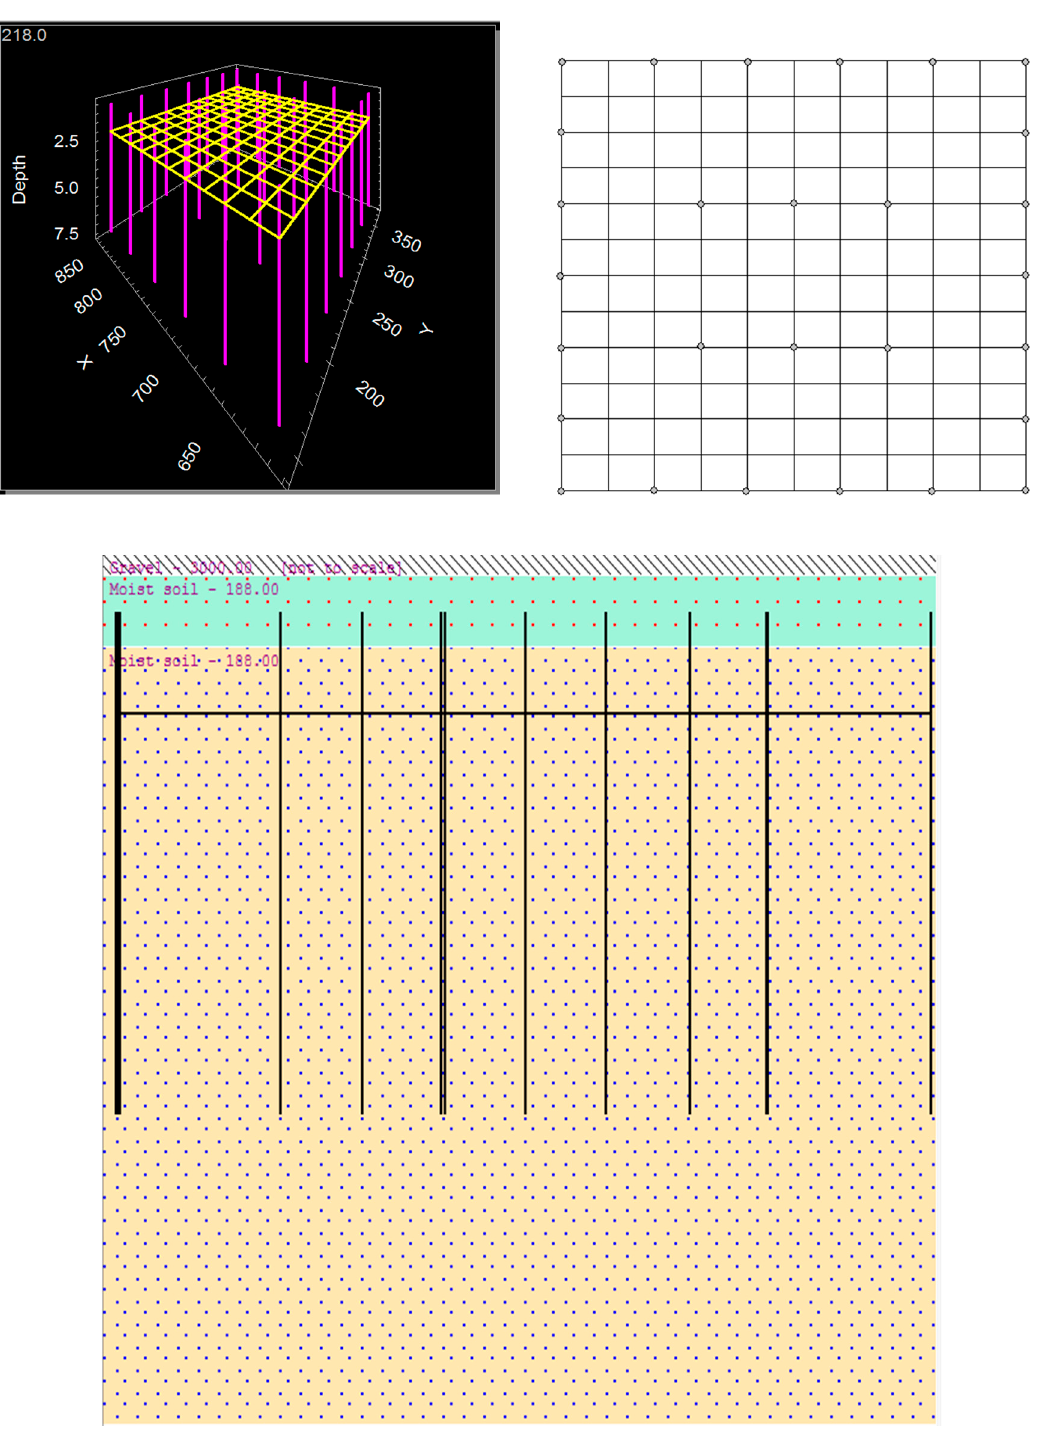
Figure 10. FEM mode grounding network completion diagram.